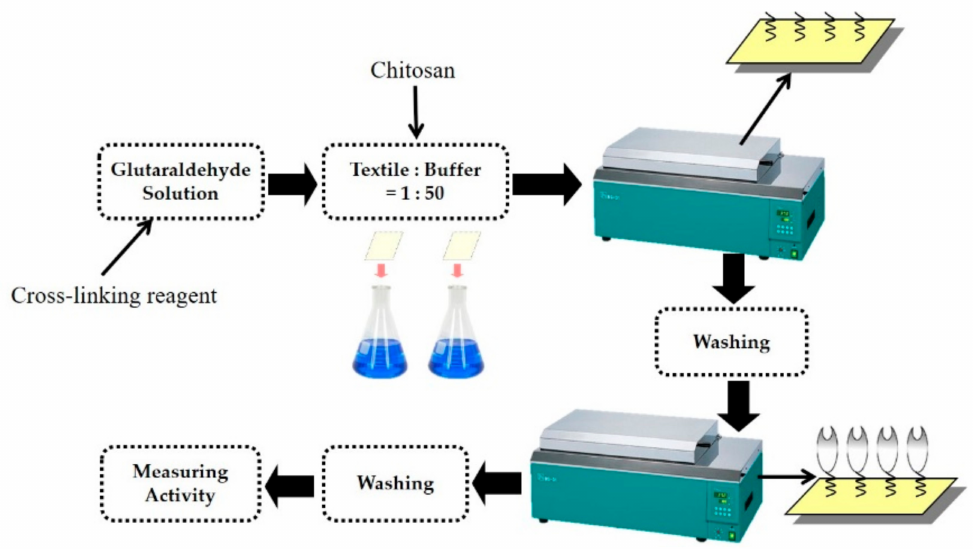
Figure 2. Schematic presentation of the trypsin immobilization process onto chitosan